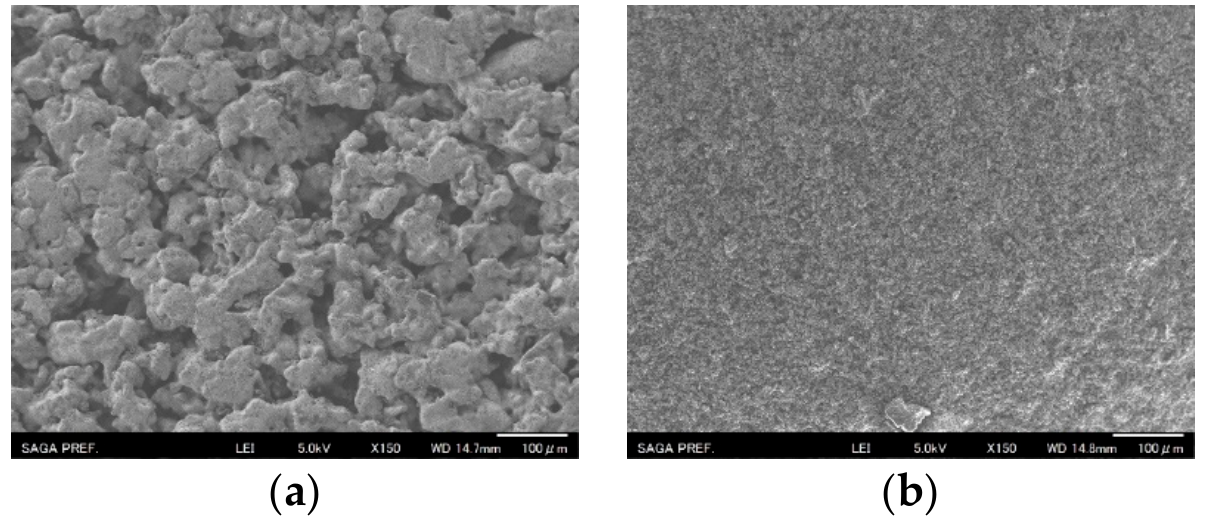
Figure 11. SEM images (100 µ m magnification) of ( a ) a stainless steel wick and ( b ) a ceramic wick. Reproduced from [25], Saga Ceramics Research Laboratory: 2019.